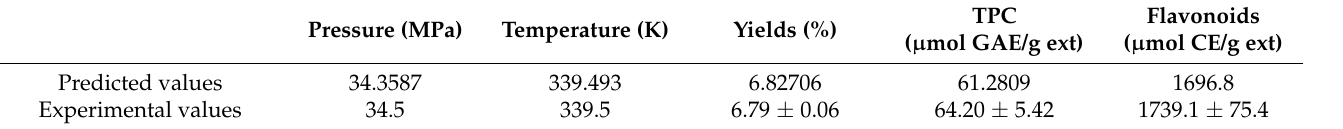
Table 4. Predicted and experimental values of the responses were obtained at the optimum conditions of the independent variables. The experimental data are given as the mean ± SD ( n = 2).